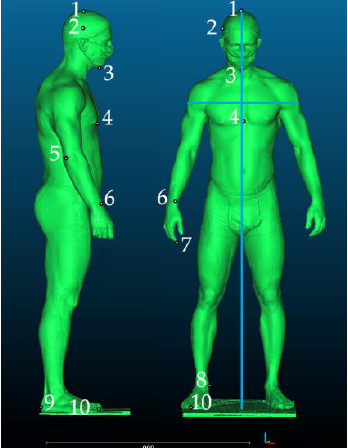
Figure 5. Anthropometric landmarks used for determining the maximum dimensions of the human body and auxiliary lines (blue) marking the width and height of geometric solids. 1–Vertex. 2—Eurion. 3—Gnathion. 4—Xyphoidale. 5—Radiale. 6—Stylion. 7—Daktylion. 8—Sphyrion. 9—Pternion.